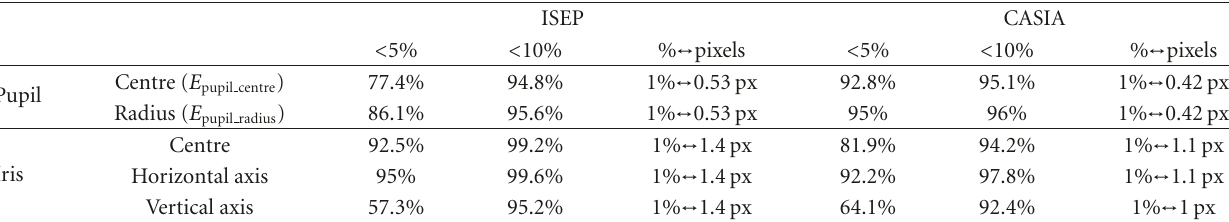
Table 1: Evaluation of the accuracy of the segmentation process.